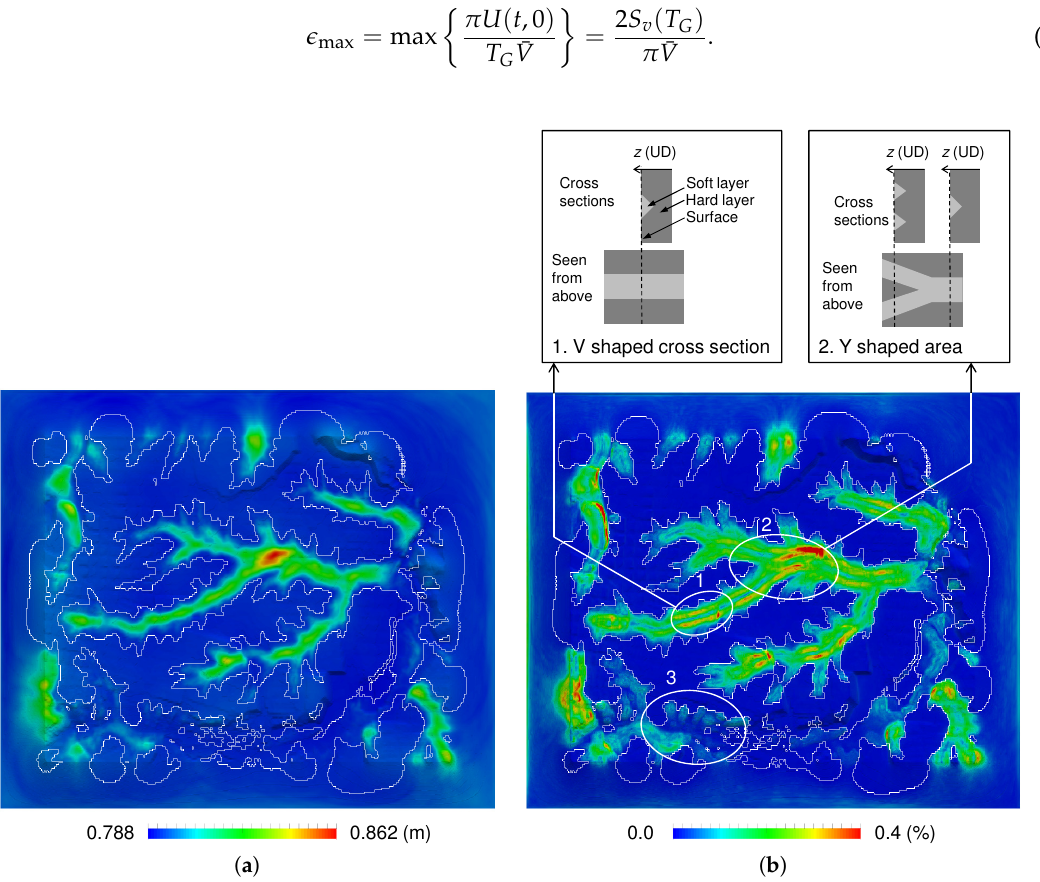
Figure 5. Distribution of the maximum displacement and maximum principal strain. White lines indicate boundary between cut-and-fill layers. ( a ) Maximum displacement. ( b ) Maximum principal